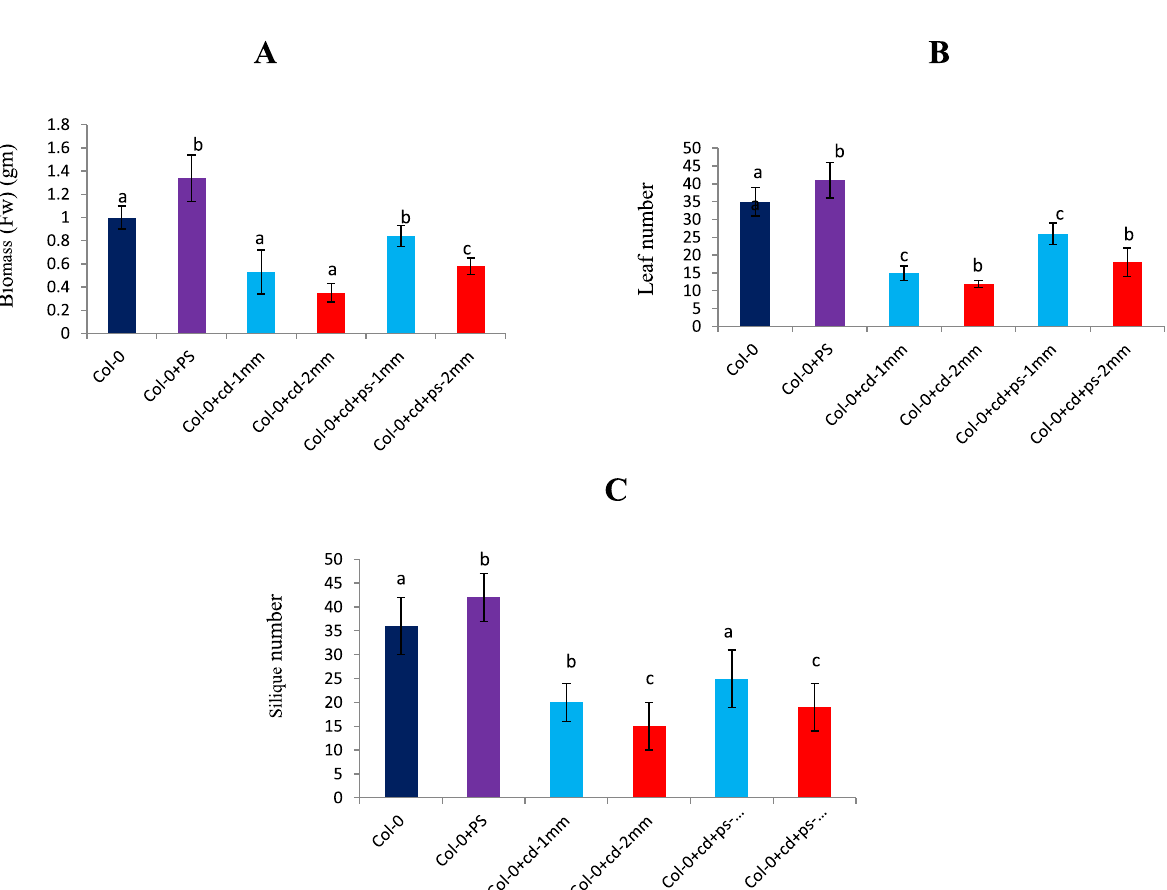
Fig. 4 Effects of Pseudomonas fluorescens on total biomass, leaf, and silique number of Arabidopsis under different CdCl2 concentrations. Values are means and bars indicate SDs ( n 6) columns with a , b , and c letters indicate statistically significant difference at P < 0.05 (Duncan test) =